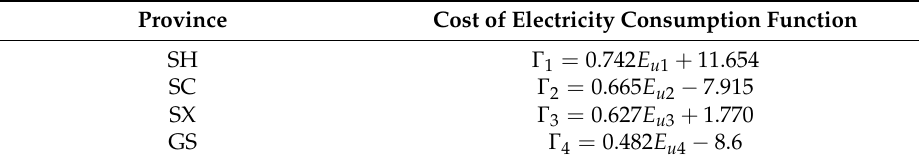
Table 5. Function for the cost of electricity consumption.